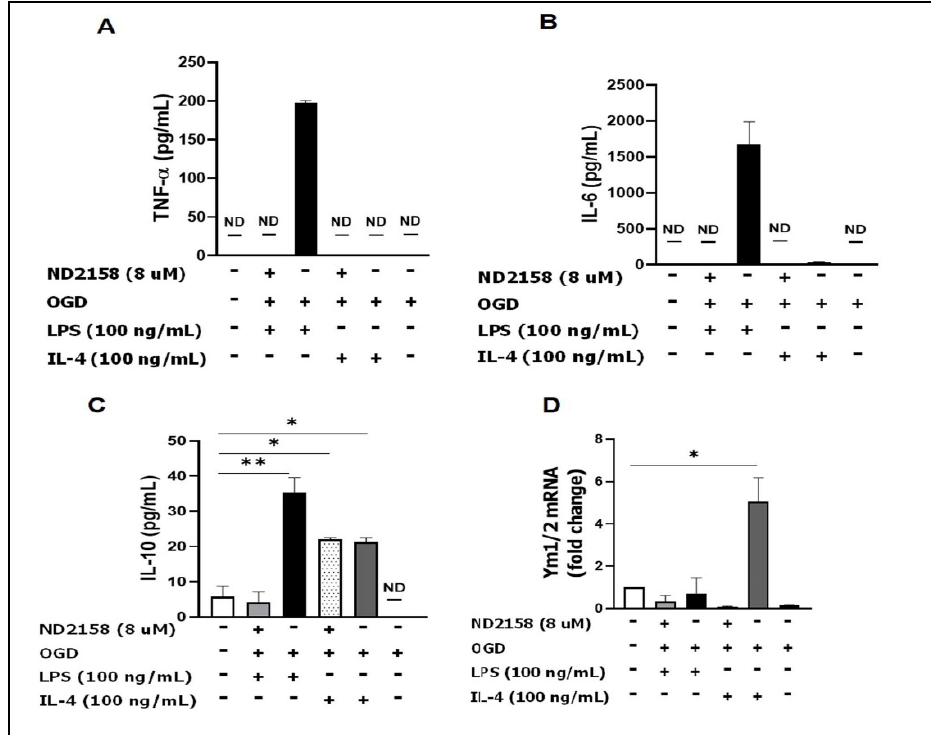
Figure 4. ND2158 treatment decreases microglial cytokine secretion. Primary microglia were cultured with 8 uM ND2158 for 24 h and stimulated with OGD for 4 h and with LPS or IL-4 for 24 h. Cytokines secreted into the culture media were measured by ELISA: ( A ) TNF-α; ( B ) IL-6; ( C ) IL-10. ( D ) Ym1/2 mRNA in cultured cell homogenates. Data were averaged from three independent experiments; ** p < 0.0001, * p < 0.05; One-way ANOVA.